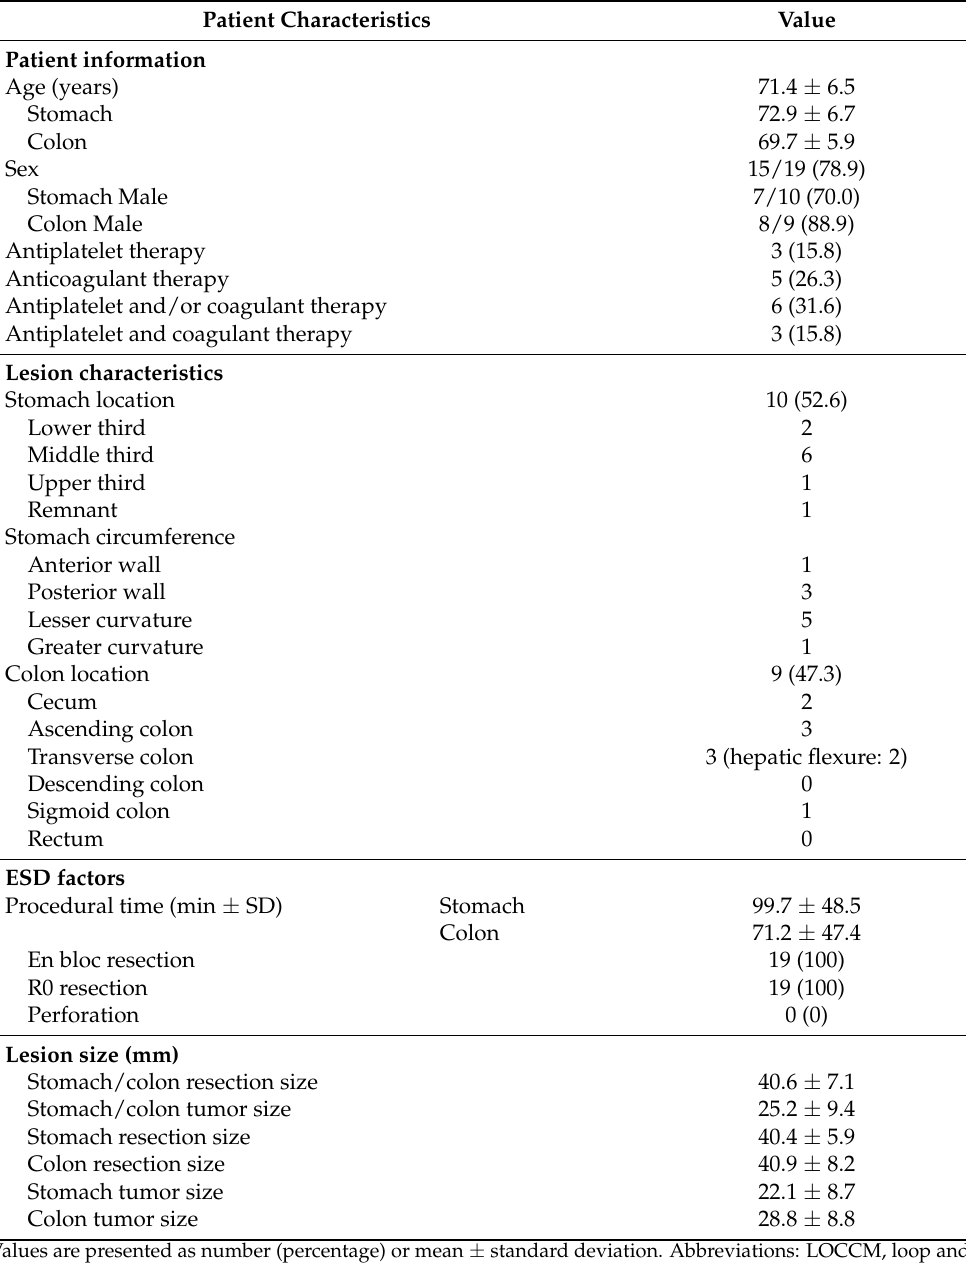
Table 1. Baseline characteristics of patients who underwent loop and open–close clip closure ( n =